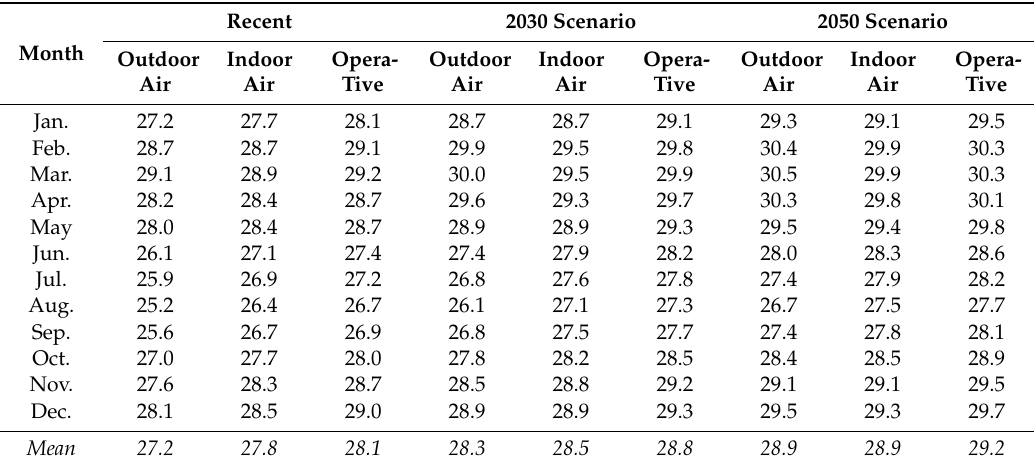
Table 5. Monthly mean outdoor air temperatures, and indoor air and operative temperatures for the whole building when simulated with the recent and future climate datasets.